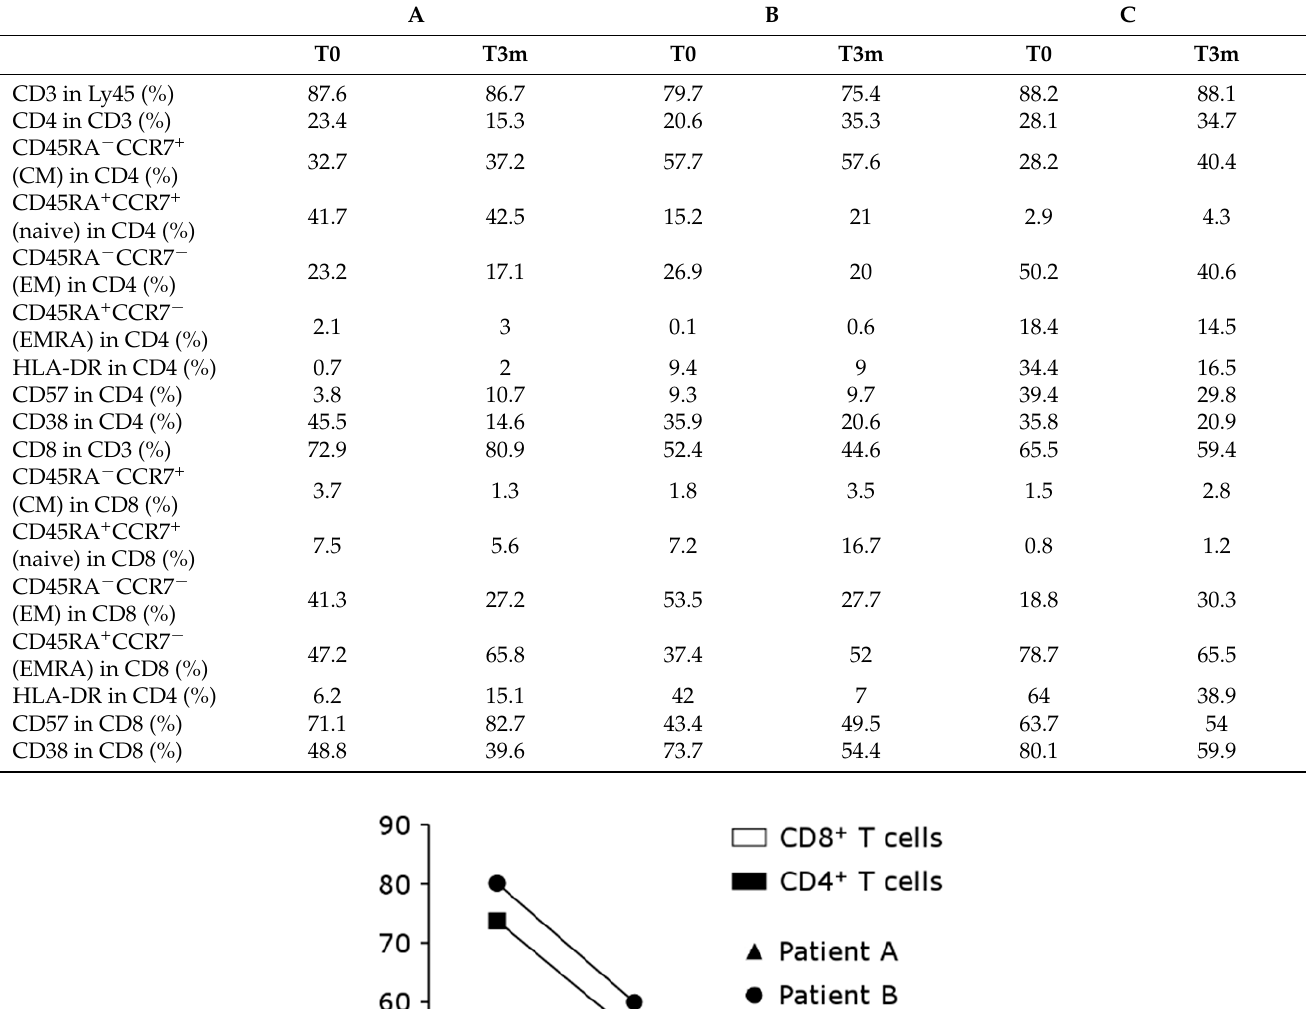
Table 2. Phenotype of peripheral lymphocytes assessed before and 3 months after mTORi introduc- tion.